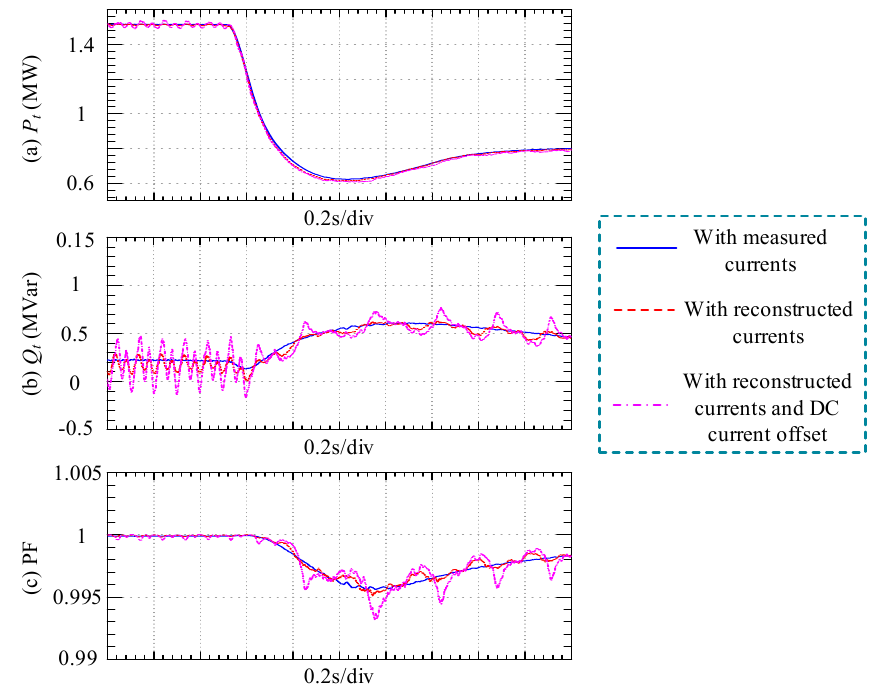
Figure 16. The total output active power P t , reactive power Q t and power factor PF under different situations.